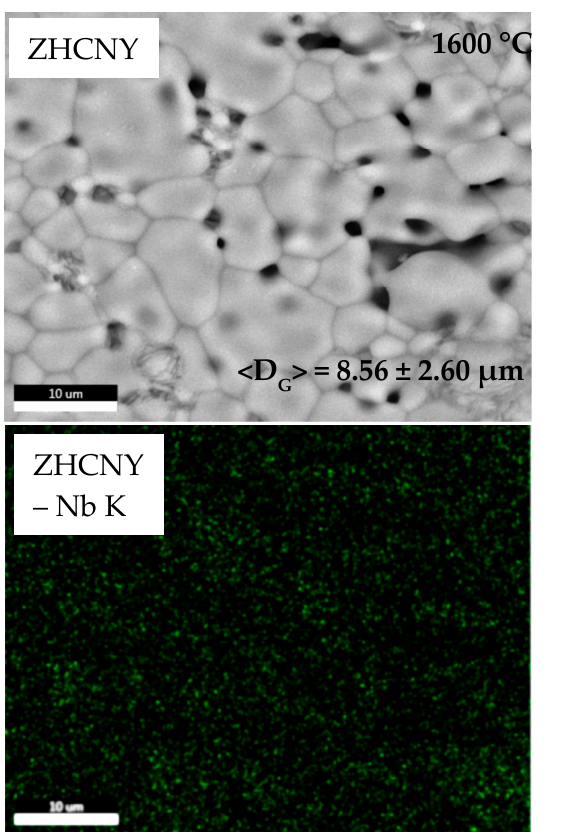
Table 2. Phase content for samples treated at 1300, 1400, 1500 and 1600 °C belonging to equimolar ZrO 2 -HfO 2 -CeO 2 -Nb 2 O 5 - Re 2 O 3 systems (Re = Y, Yb, Nd, Gd).